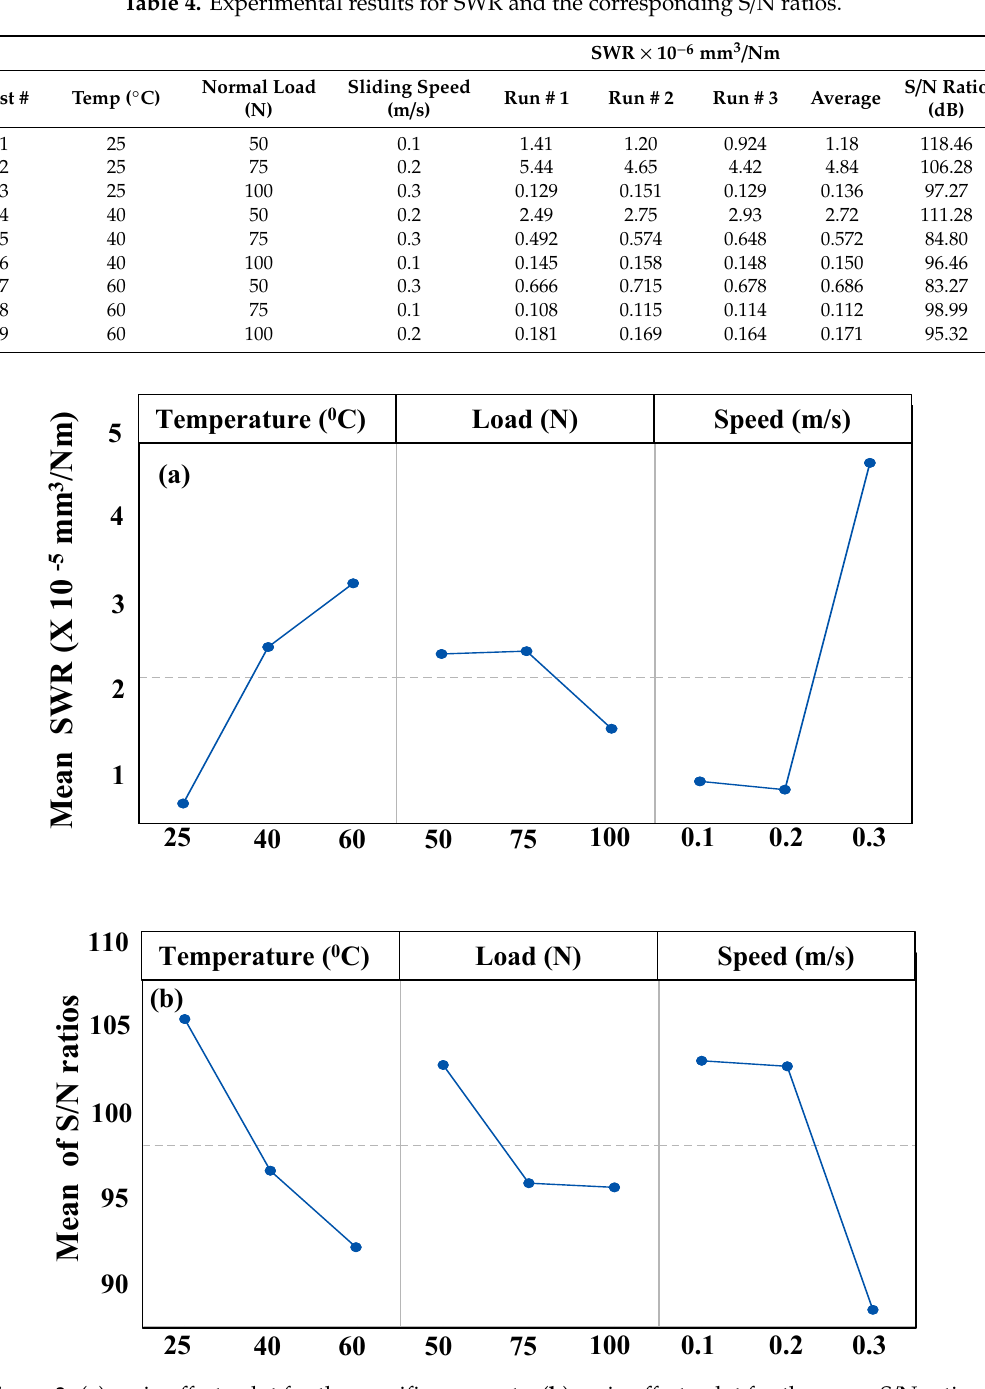
Table 4. Experimental results for SWR and the corresponding S/N ratios.